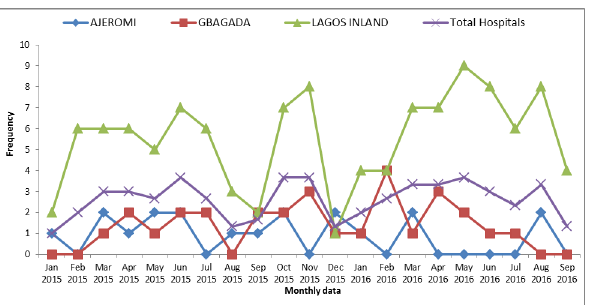
Fig 1. Trends in Maternal Mortality ratio by months in the three hospitals and overall trends. A wide variation in maternalmortality ratio was observedamong the three Hospital in 21-month period.